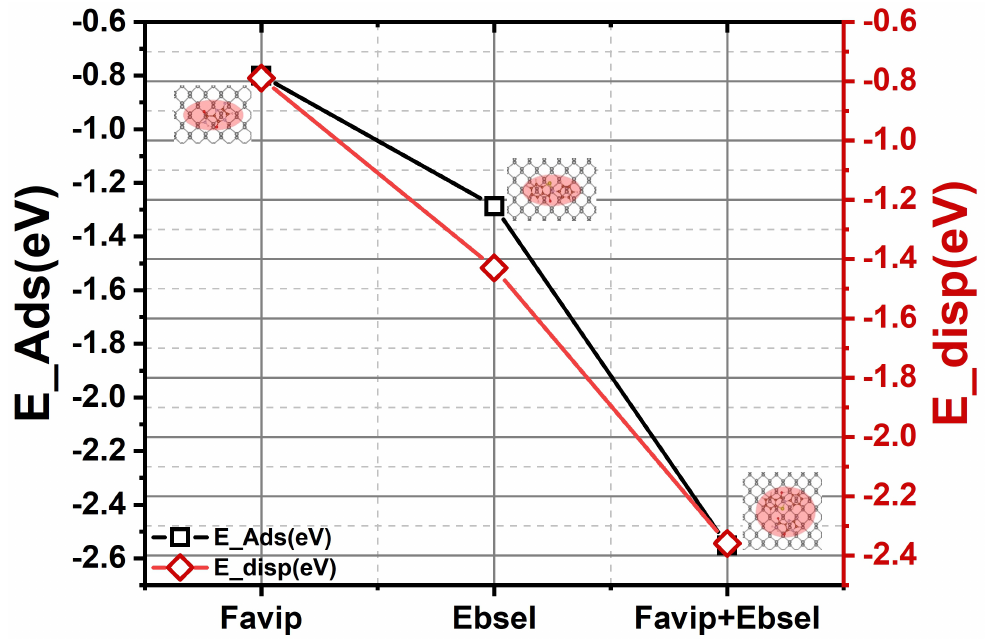
Figure 1. Adsorption and dispersion energy of favipiravir, ebselen, and favipiravir+ebselen hybrid molecules, respectively. Table 1. The drug–BP adsorption distance d–d (in Å), van der Waals energy, binding energy, inter- action energy, and covalently energy (in eV), corresponding to the different drugs identified in this work as evaluated by the PBE–D3(BJ)